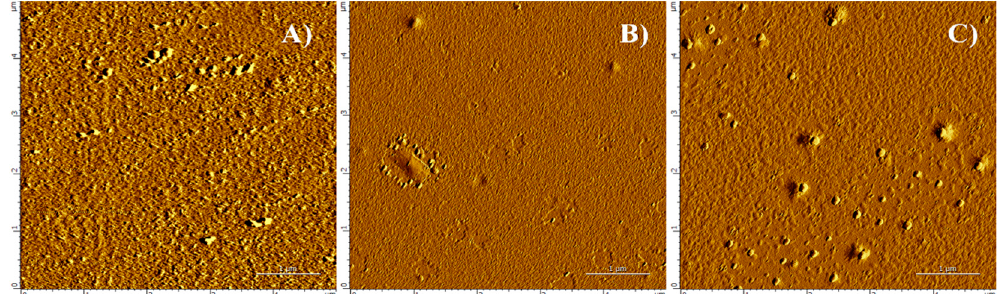
Figure 1. Atomic force microscope (AFM) 2D images of ( A ) bare glass slide, ( B ) undoped TiOx, and ( C ) Eu-doped TiOx thin films.